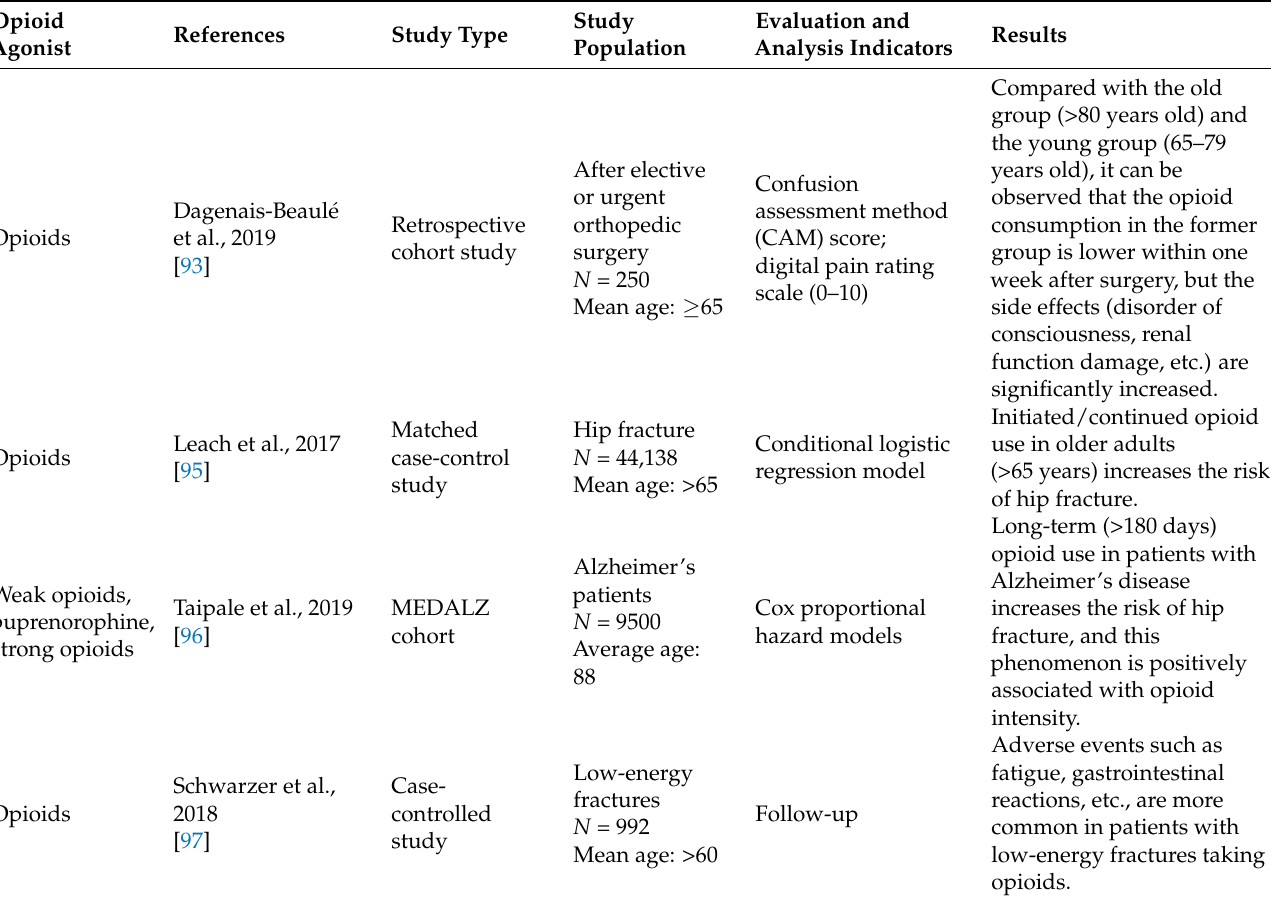
Table 2. Opioid agonists and its related clinical